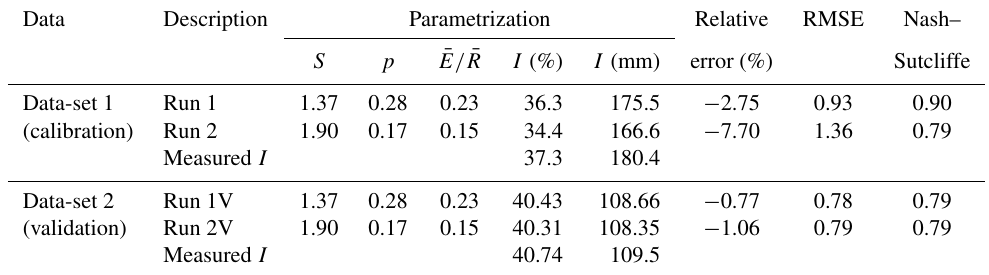
Table 6. Comparison of the performance of modelled interception loss using different parametrization. Data-set 1 refers to the period from